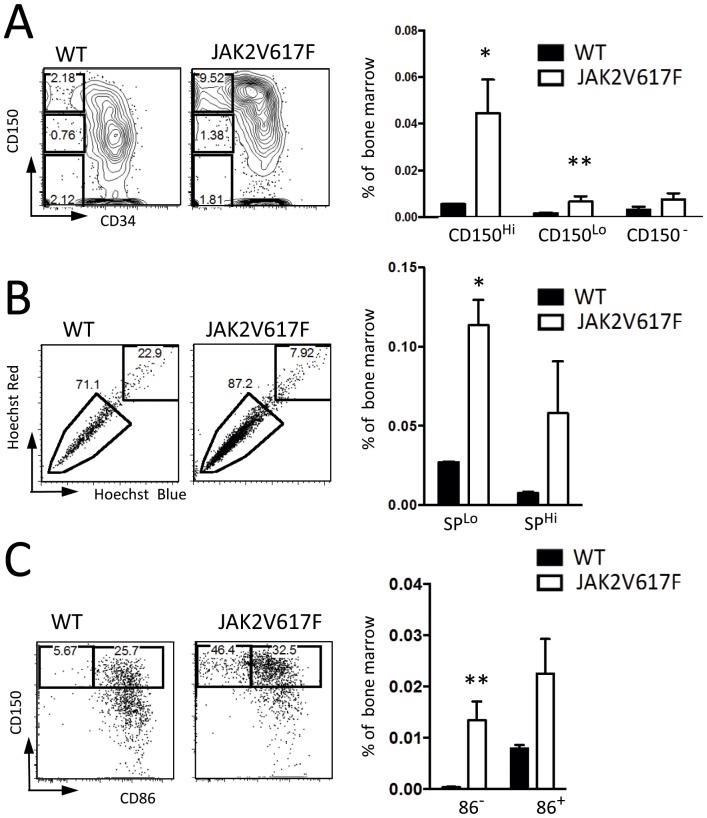
Particular HSC subsets expand in JAK2V617F Tg mice.(A) LSK were resolved with CD150 and CD34. CD34− CD150Hi, Lo, and negative HSC were gated as described by Morita [10]. The percentages of CD34− HSC subsets in BM were calculated. Closed and open circles indicate individual WT and JAK2V617F mice, respectively. The data are representative of those obtained in two independent experiments (N = 6). (B) Lower side population cells in BM (spindle-shaped gating) are thought to include myeloid biased HSC. The “side population tip” was increased in JAK2V617F mice. Representative plots are shown in the left panels, while cell percentages of lower and upper cells are given in right panels. (C) Both CD86− and CD86+ CD150+ CD48− LSK cells in BM were increased in JAK2V617F mice. CD48− LSK were resolved with CD86 and CD150. Cell percentages of CD86− and CD86+ in CD150Hi were calculated. The data are representative of those obtained in three independent experiments (N = 8) p<0.01(**), p<0.05(*).